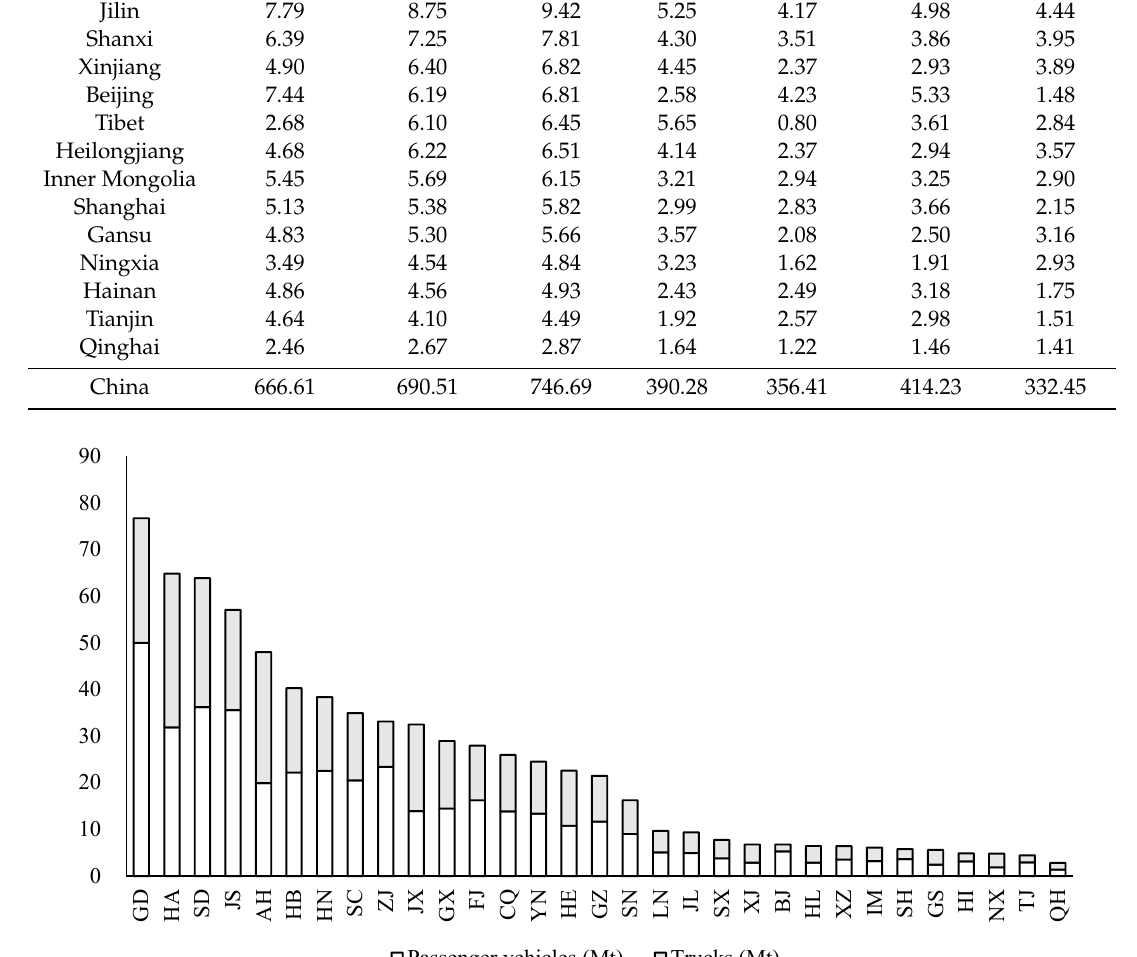
Figure 7. Provincial projections of gasoline and diesel consumption in 2035. Table 6. Comparisons of projections of the fuel demand in China. Source